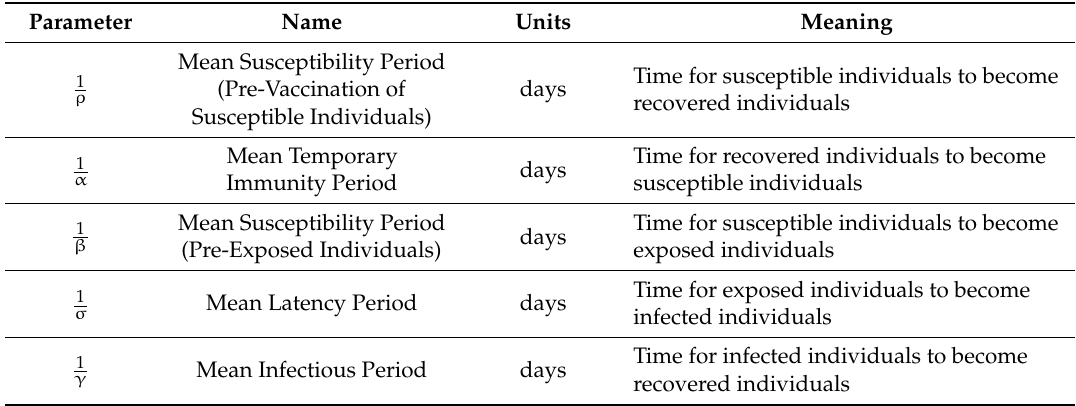
Table 3. Description of Inverse Model